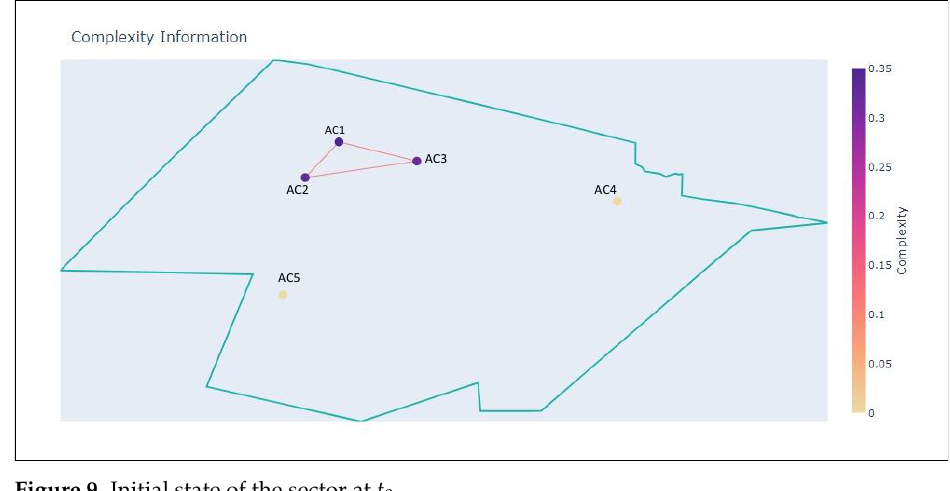
Figure 9. Initial state of the sector at t 0 .